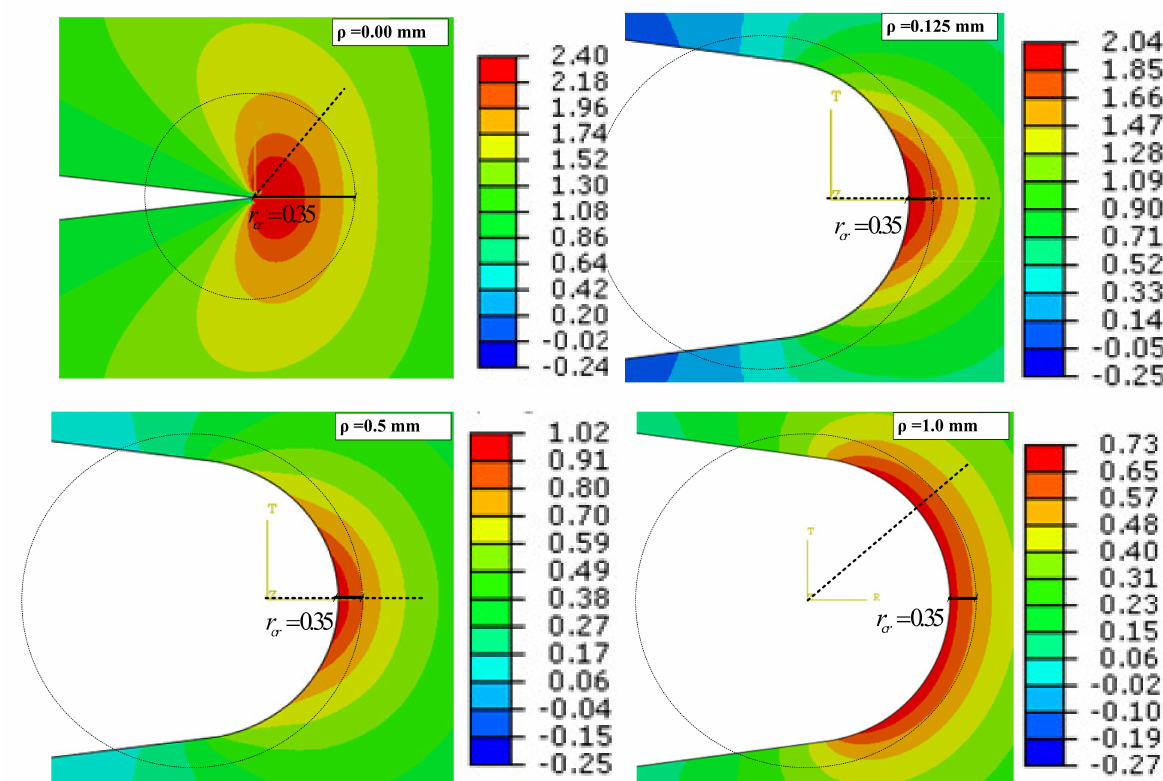
Figure 14. Numerical TS variations around blunt V-notch edge in DCB 1 specimens with different notch root radii ( γ = 15 ◦